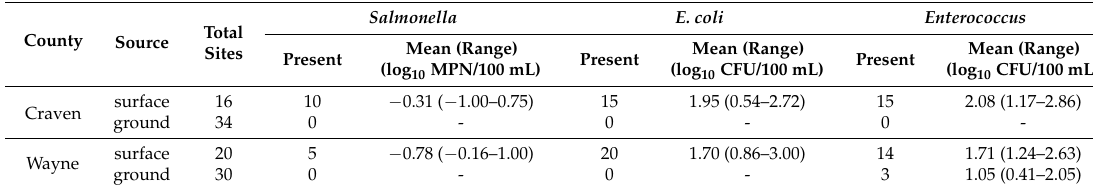
Table 1. Bacteria in surface and groundwater sites.